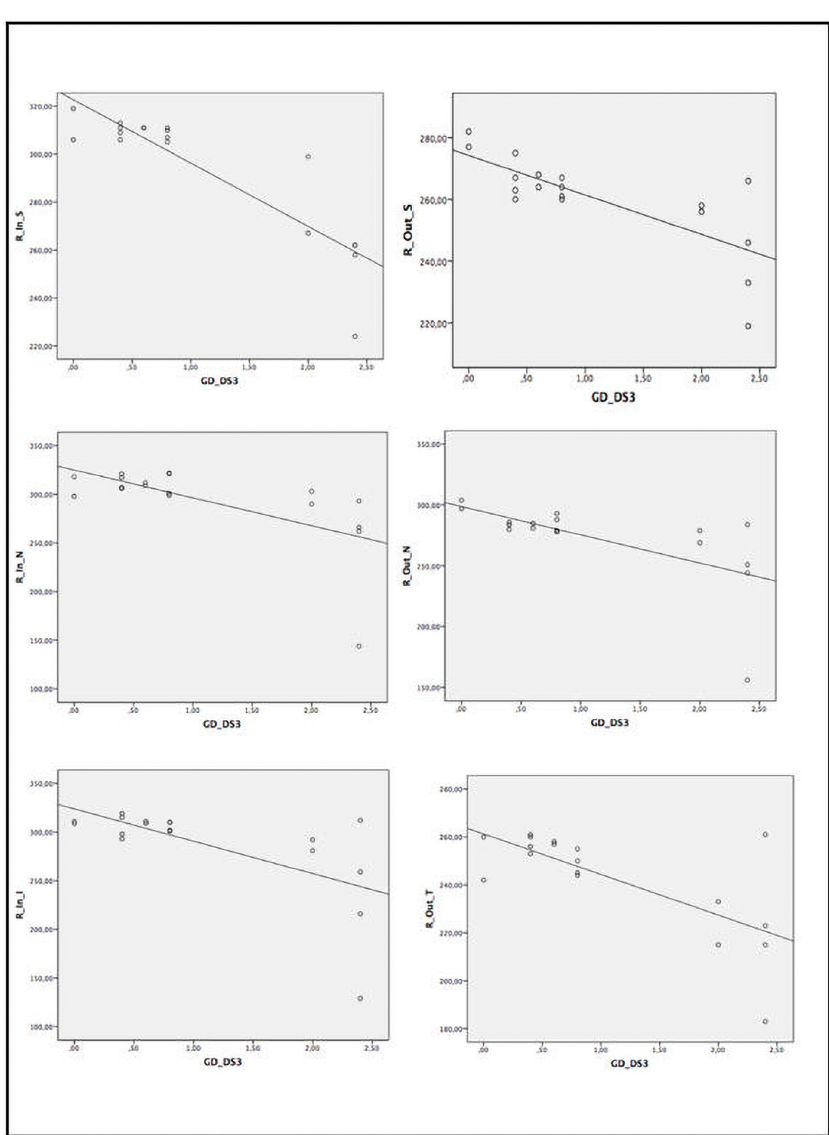
Fig 2. Moderate and strong correlation (r > 0.6) between retinal thickness by SS-OCT and GD-DS3